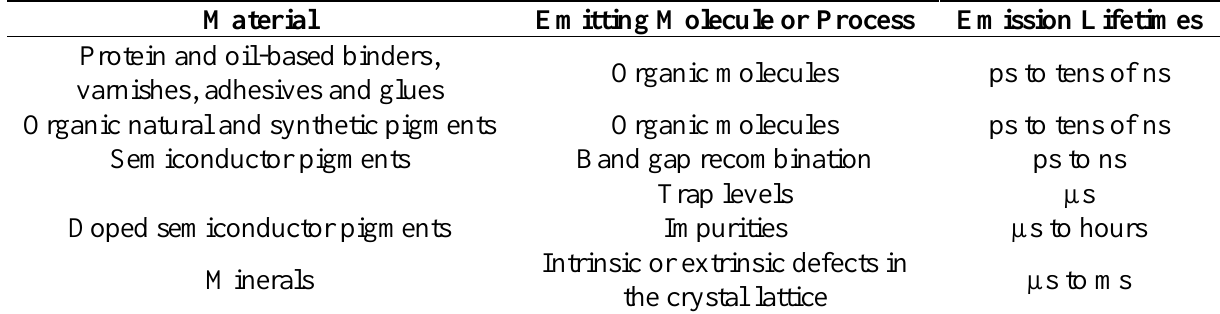
Table 1. Emission lifetimes of typical luminescent materials found in cultural